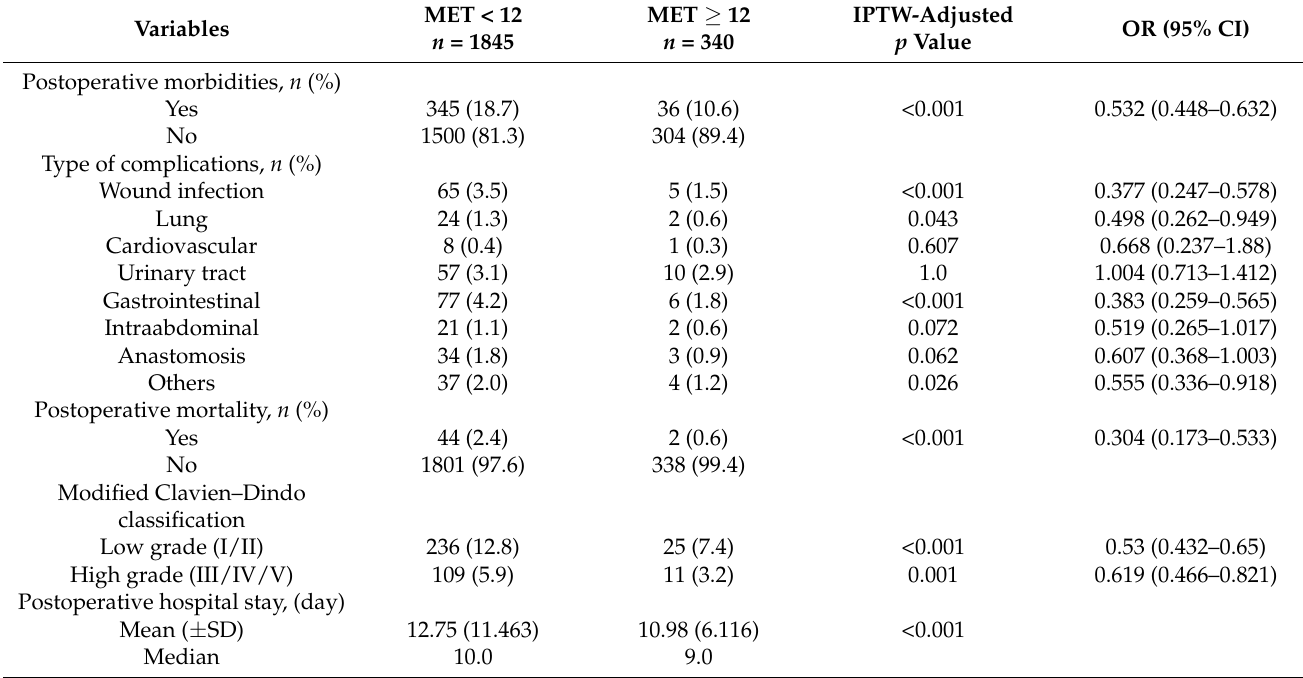
Table 2. Comparison of short-term outcomes between the weekly MET < 12 and MET ≥ 12 groups after weighting.